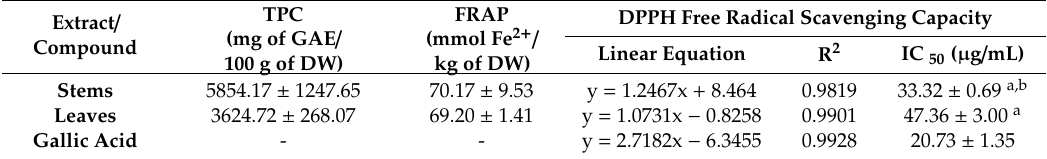
Table 2. Total phenolic content (TPC), ferric reducing antioxidant power (FRAP), and IC 50 values of leaves and stems of U. bojeri